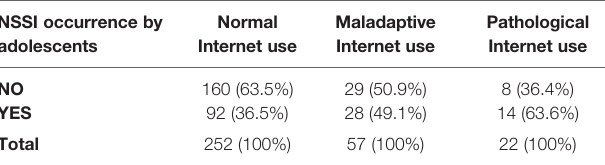
TABLE 3 | Occurrence of NSSI by internet use groups (normal, maladaptive, pathological) (how many people have NSSI by internet use groups). NSSI occurrence by adolescents